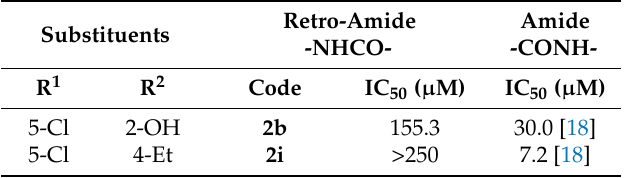
Table 7. Comparison of in vitro HepG2 cytotoxicity of prepared N -pyrazinylbenzamides (retro-amides) with corresponding N -phenylpyrazine-2-carboxamides